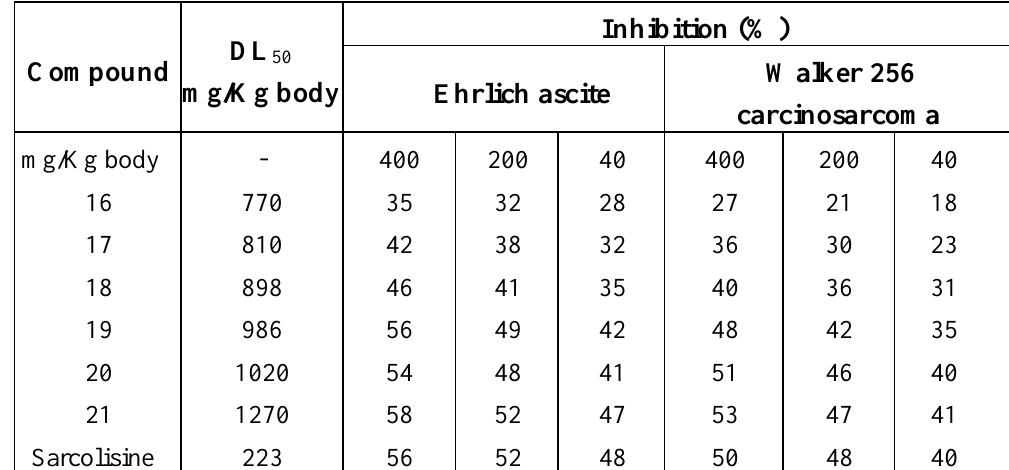
values and inhibition (%) induced by the N-mustards 16-21 on some Table 1. DL 50 experimental